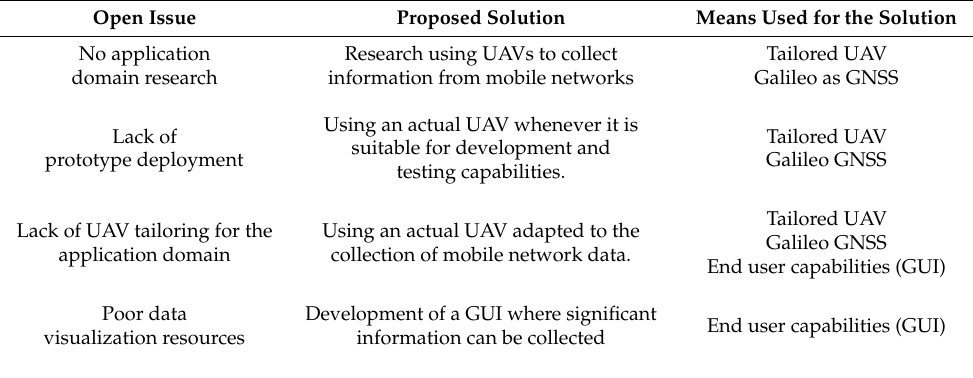
Table 2. Solutions to the open issues provided by the proposed